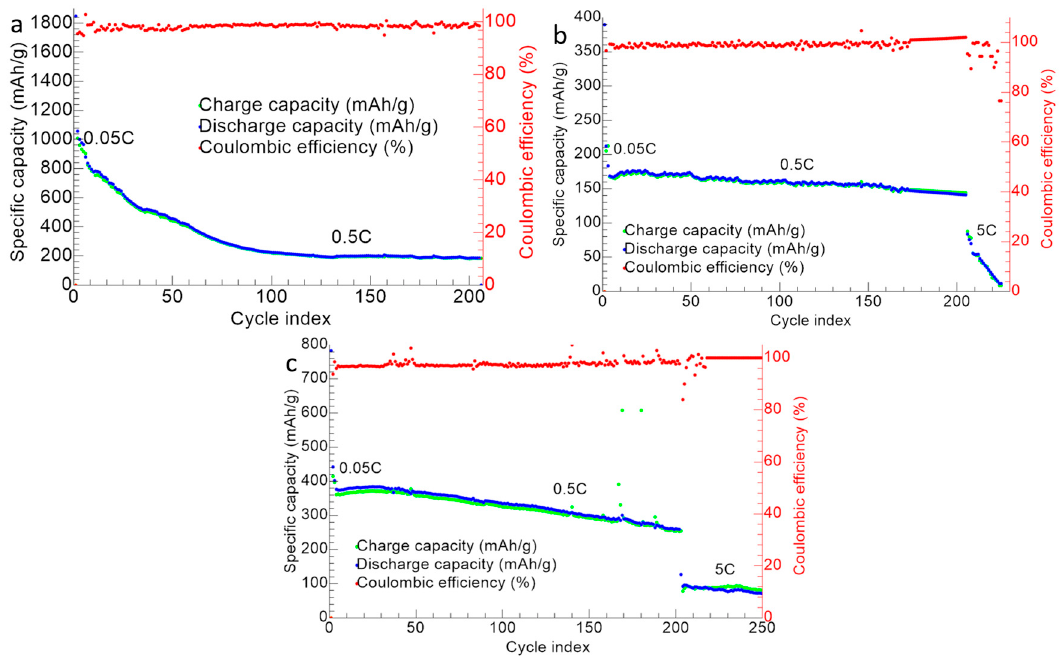
Figure 13. Cycling performance of ( a ) ZnS–GO, ( b ) 10%ZnS–GO/CNF and ( c ) 30%ZnS–GO/CNF samples. Charge (green), discharge (blue) and coulombic e ffi ciency (red).